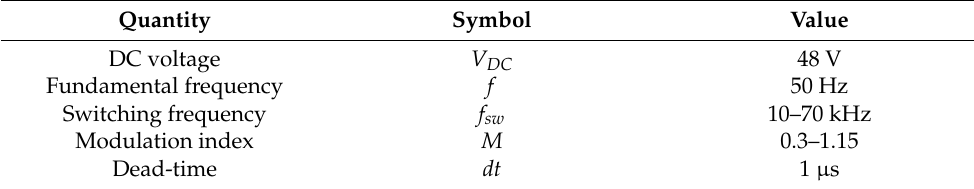
Table 5. Main electric quantities of the converter